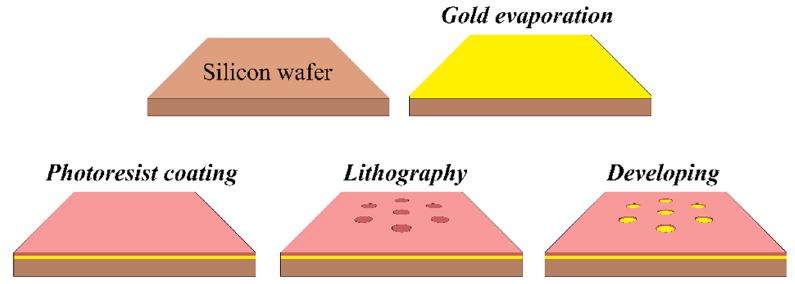
Figure 2. Scheme for obtaining microelectrode